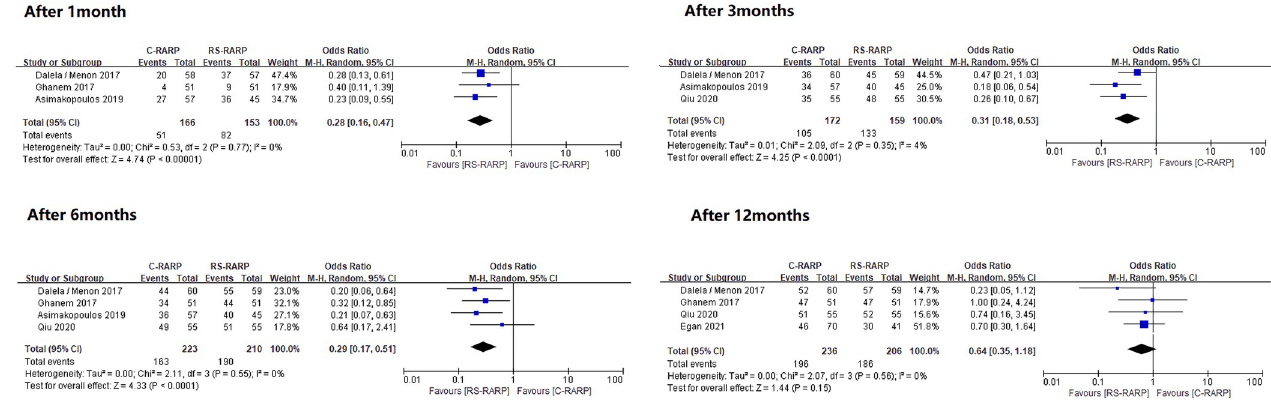
Fig 2. Forest plots of recovery of continence after surgery_zero pad definition.